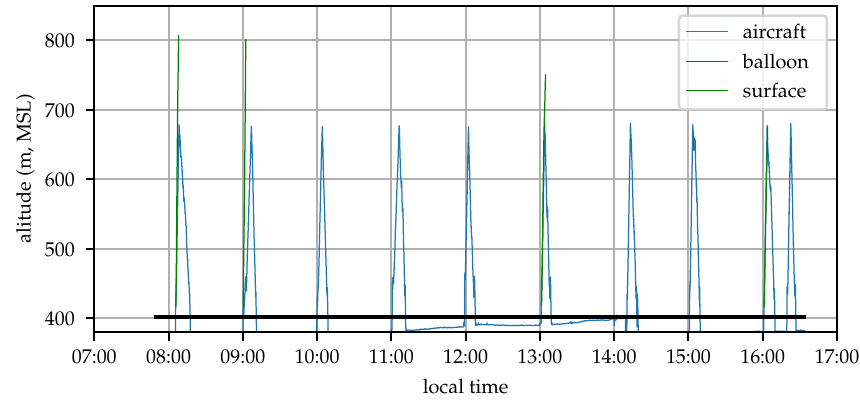
Figure 12. Time history of aircraft and balloon altitude (2018-12-06). The aircraft appears to be below ground between flights because its state estimator is incorporating airspeed measurements which are not informative when on the